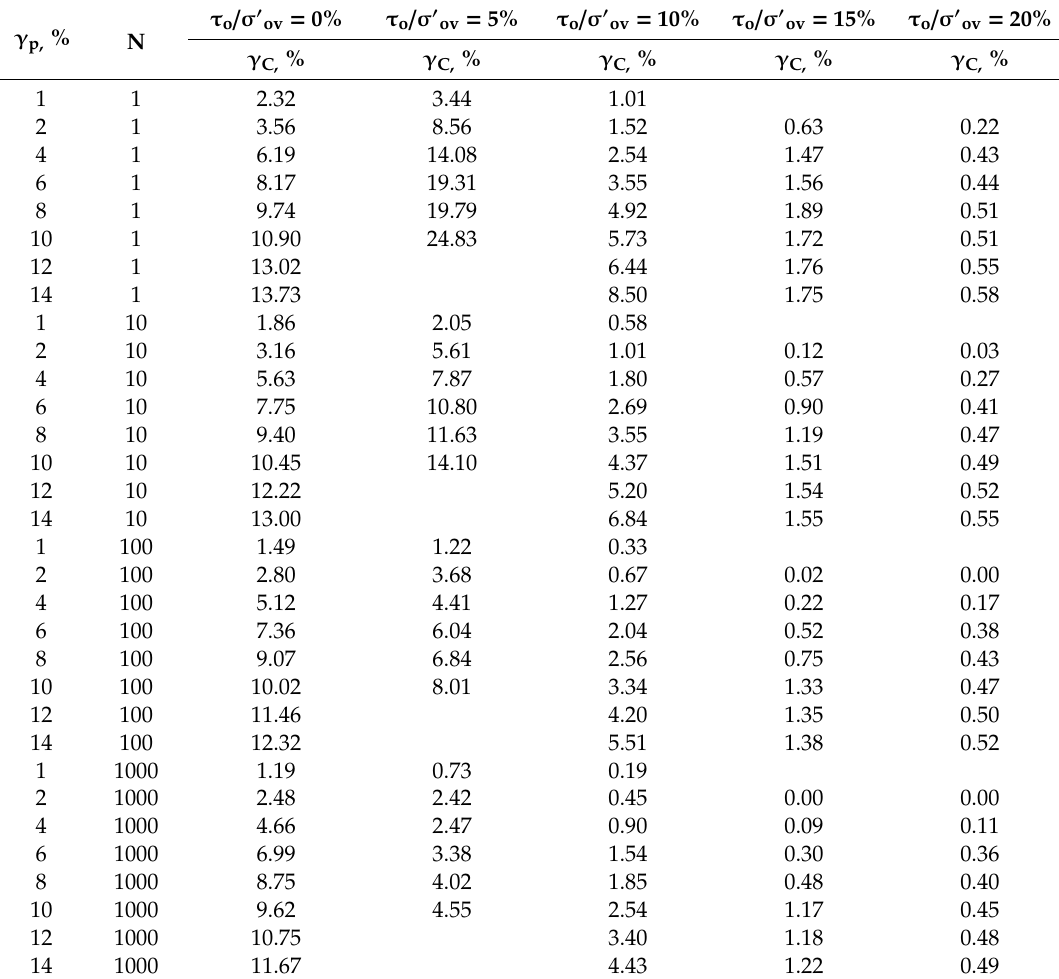
Table 10. Values of γ p and γ c as a function of N and τ o / σ (cid:48) ov